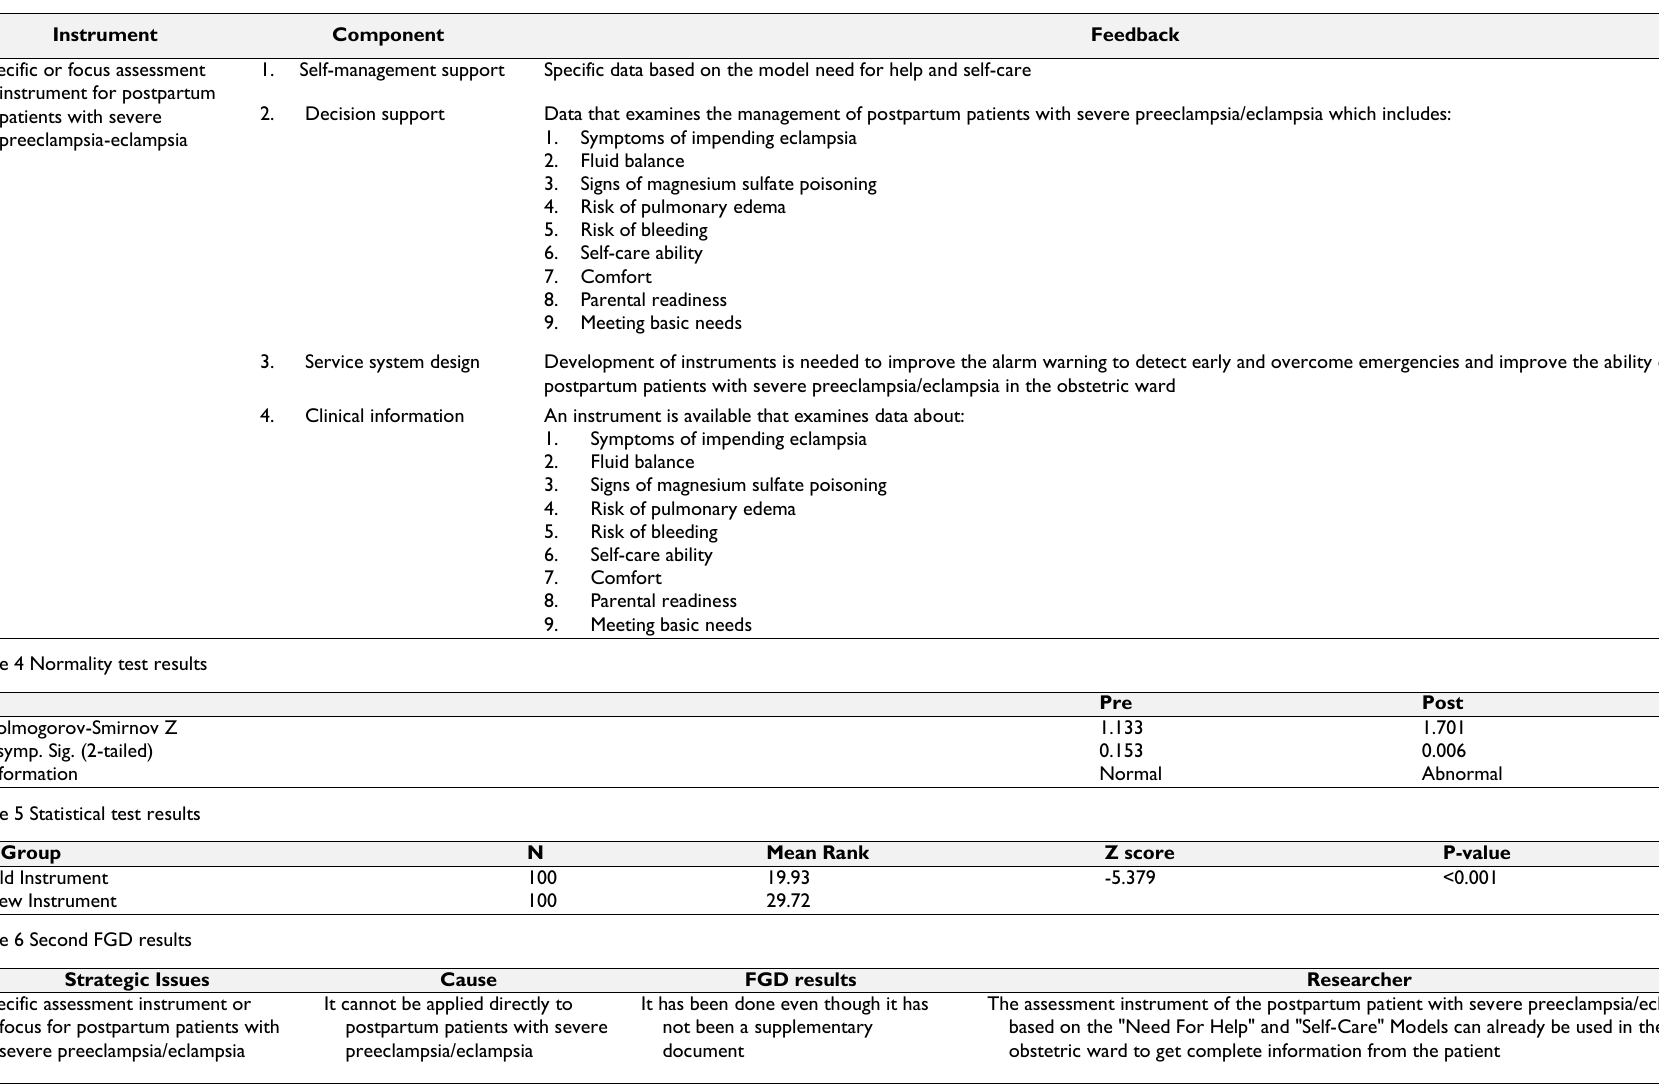
Table 3 Results of expert discussions